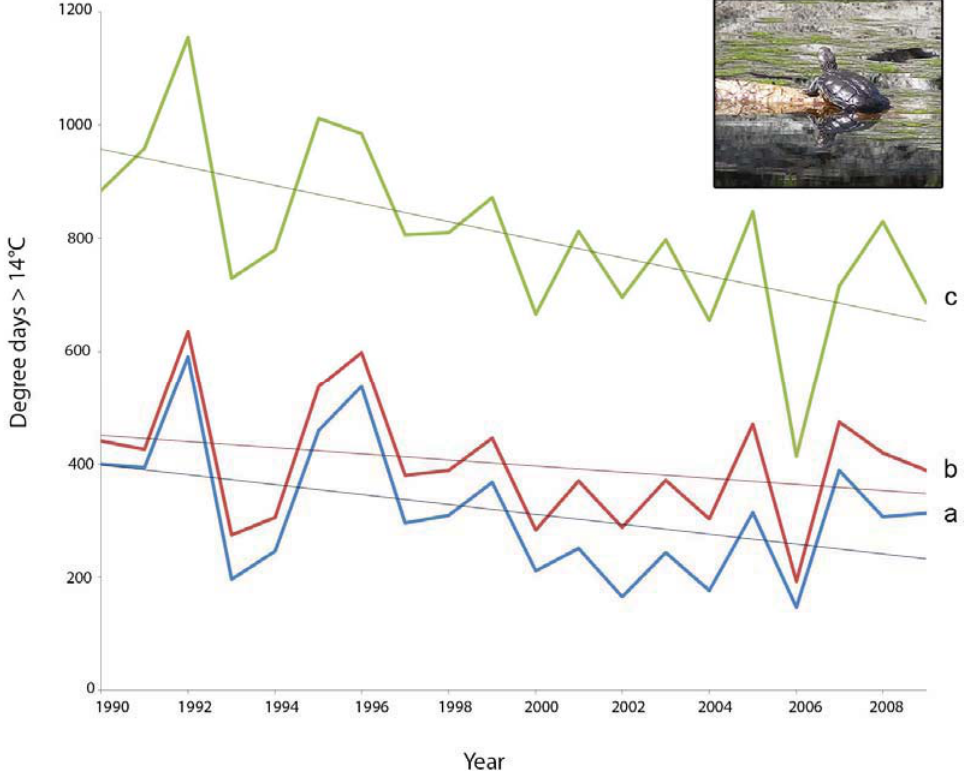
Figure 4. Sensitivity analysis showing how the structure of the behavioral subroutine in NicheMapR influences the degree day predictions over 20 years at Ellen Brook Nature Reserve. The blue line indicates no basking (scenario a in Figure 3), the red line indicates an option to bask when water temperatures fall below 14 °C (scenario b in Figure 3), and the green line indicates that tortoises always seeks the warmest thermal environment above a threshold of 14 °C, which would usually be out of the water (scenario c in Figure 3; e.g., inset photograph of a basking Western Swamp Tortoise by